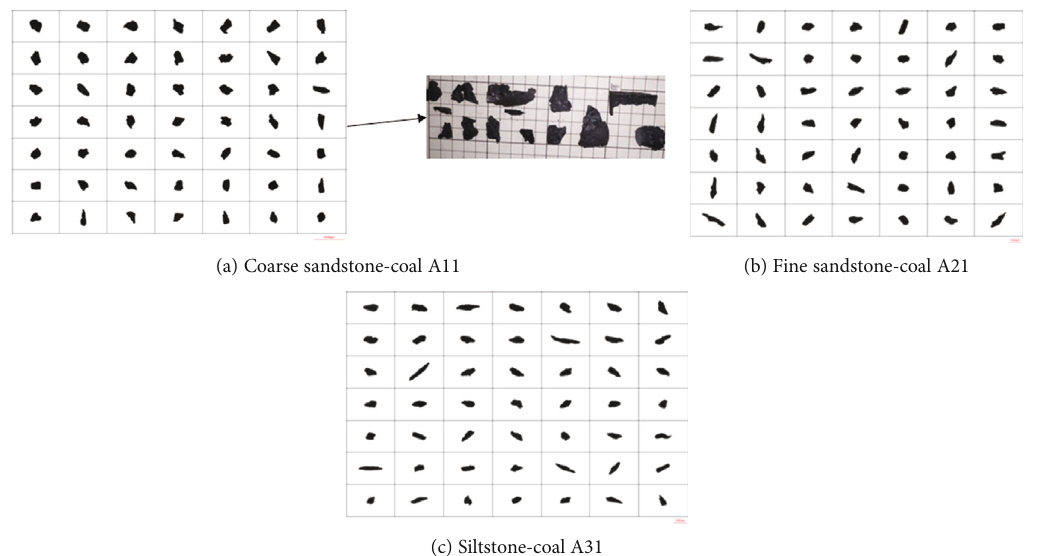
Figure 12: The particle size statistics of the crushed coal samples after the failure of the di ff erent lithology combination